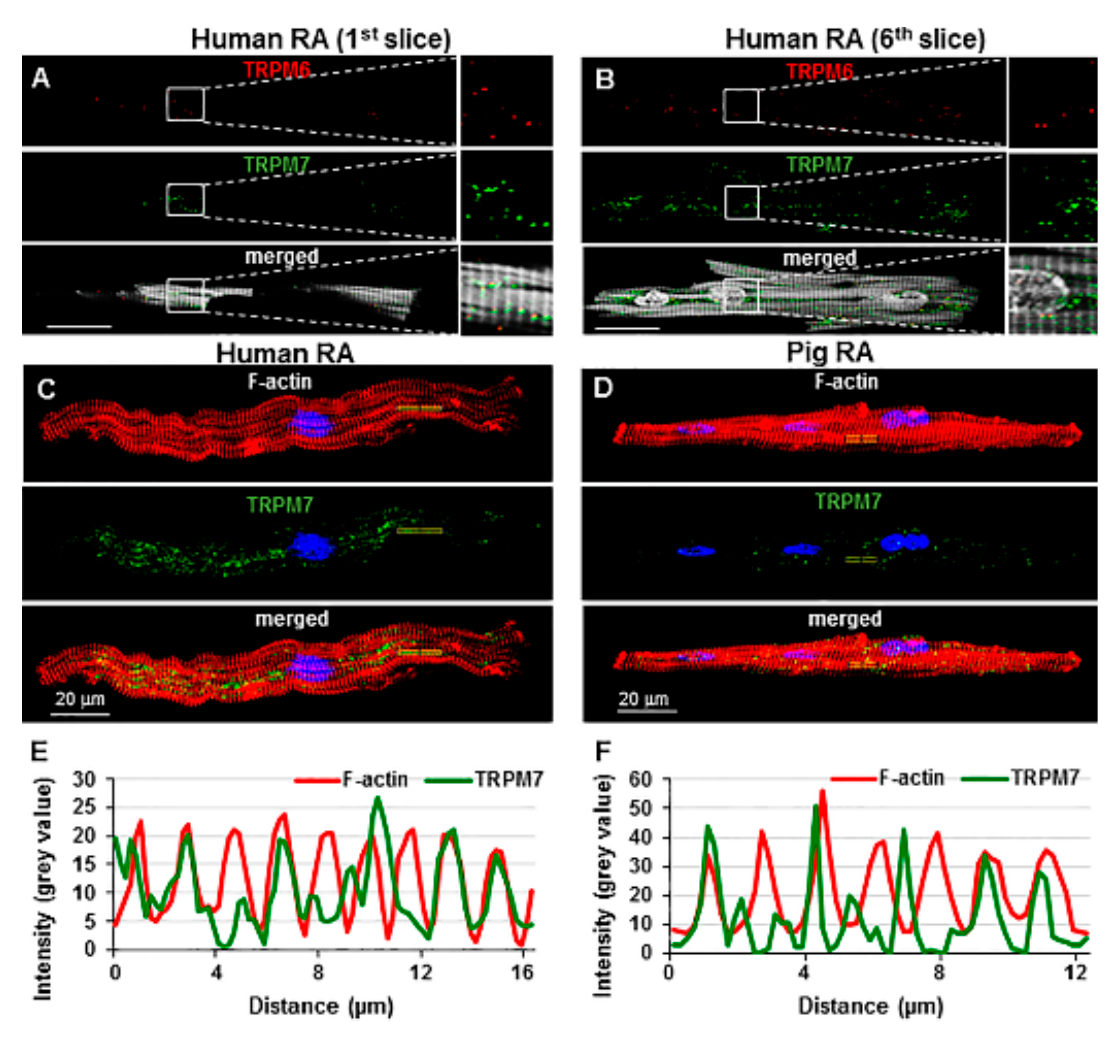
Figure 2. Detection of TRPM6 and TRPM7 in the same cell and cellular localization of TRPM7: ( A , B ) Images of human RA cell illustrating the localization of TRPM6 (red) and TRPM7 (green) proteins in the same cardiomyocyte obtained using primary antibodies conjugated with Alexa Fluor 546 and Alexa Fluor 488, respectively, at different scanning layers [( A ), near the cell surface and ( B ), deeper in the cell towards the middle of its thickness]. Phalloidin-CF 405 for F-actin cytoskeleton and Hoechst 33342 for nuclei appear in surrogate grey; ( C , D ) immunofluorescence images of TRPM7 (stained in green when using Alexa Fluor 488) and F-actin cytoskeleton (stained in red when using Phalloidin-Alexa Fluor 546) were used for calculating fluorescence intensity in human ( C ) and pig ( D ) RA cardiomyocytes presented in ( E ) and ( F ). Hoechst 33342 for nuclei appears in blue. Scale bars indicate 20 µm; ( E , F ) constructed graphs of the fluorescence intensity using stacks of 12 slices for the localization of TRPM7 (green) and F-actin (red) along lines of interest on the cardiomyocytes merged images. The sampling distance in depth between scanned slices was 1 µm. The calculated correlation coefficient between F-actin and TRPM7 peaks (at a place as indicated) was 0.32 for human ( E ) and 0.11 for pig ( F ) RA cardiomyocytes.